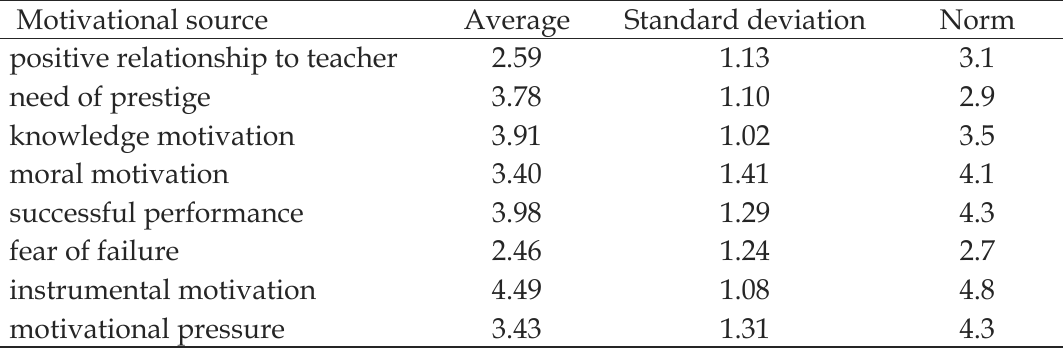
Motivational source